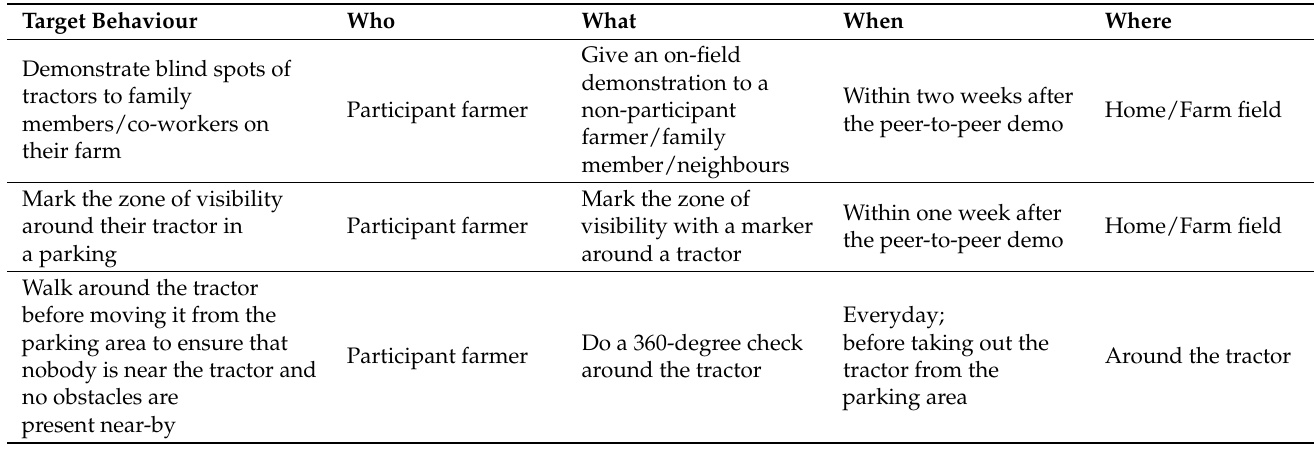
Table A2. Target behaviours.